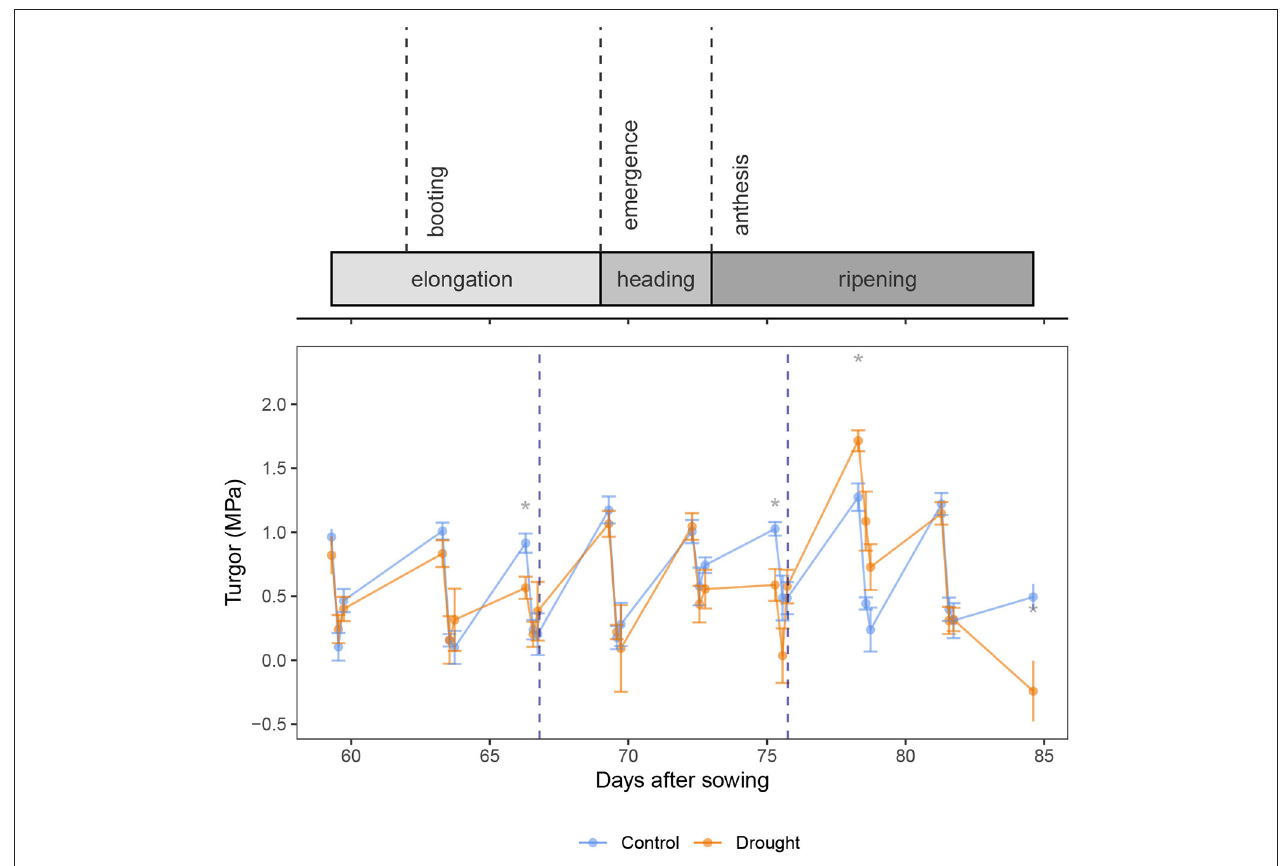
FIGURE 3 | Calculated turgor (MPa) present in the flag leaves of the wheat plants. Rewatering events are marked with a blue dotted line. The control and drought treatment are depicted in blue and orange, respectively. Mean ( n = 5) and standard error are depicted and the means are connected with lines to improve the visibility of the trends. Significant differences between the control and drought treatment are indicated above the measurements. Significance levels: * p < 0.05.